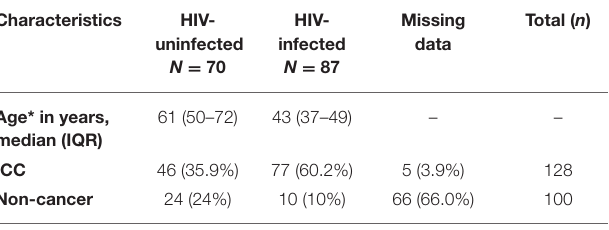
TABLE 1 | Demographic and clinical characteristics of study subjects by HIV status. Characteristics